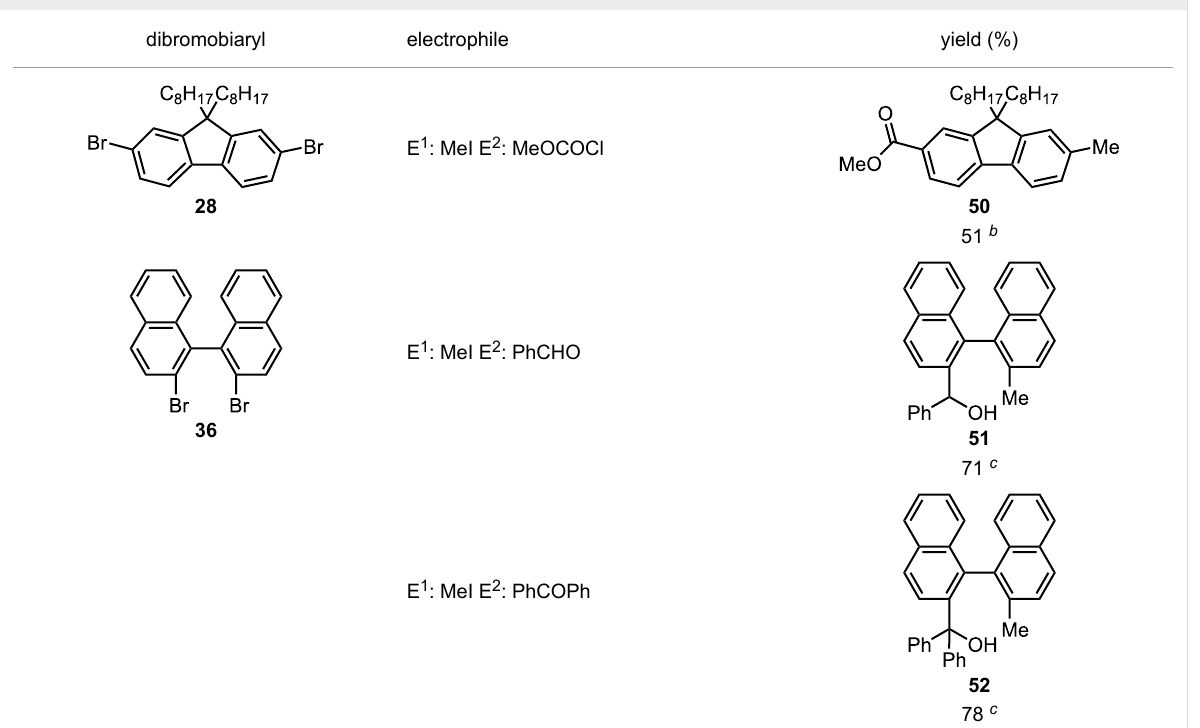
Figure 3. As summarized in Table 7, the sequential introduc- tions of two electrophiles were achieved successfully without isolation of a monobromo biaryl